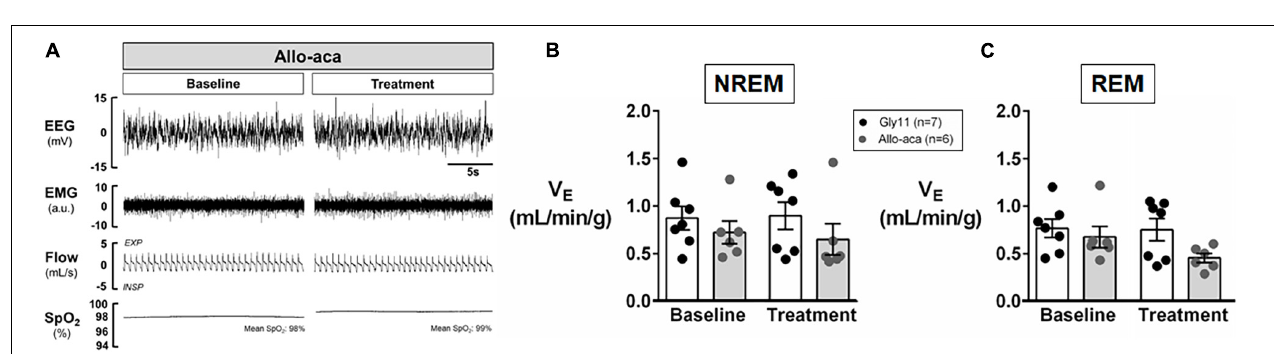
FIGURE 4 | Hypoxic ventilation was not affected by the blockade of leptin receptors with Allo-aca. Allo-aca and control peptide Gly11 did not change minute ventilation (V E ) at (A) normoxia (20.9% O 2 , 0.4% CO 2 ) and (B) hypoxia (10% O 2 , 3% CO 2 ), and (C) the hypoxic ventilatory response (HVR). Data were normalized by body weight. SpO 2 , oxygen saturation. Mixed regression model.